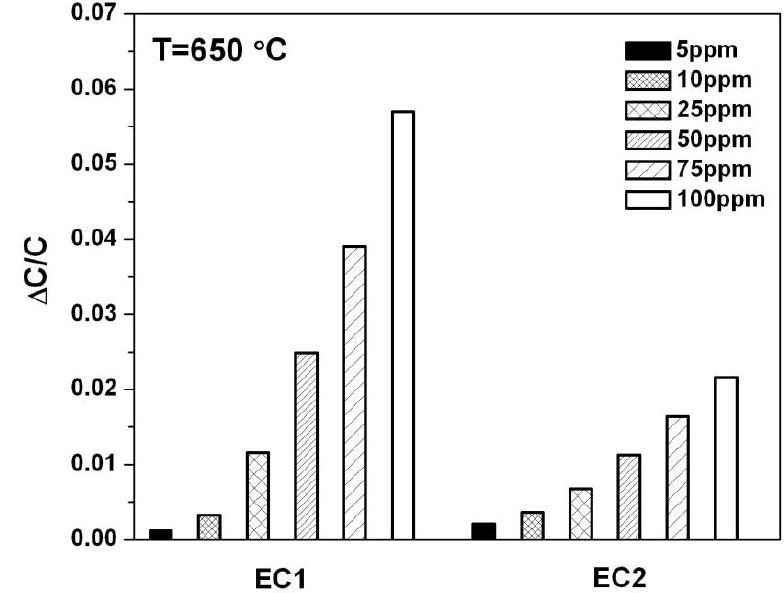
Figure 4. The change in capacitance is plotted for EC1 and EC2 sensors for NO concentrations ranging from 5 to 100